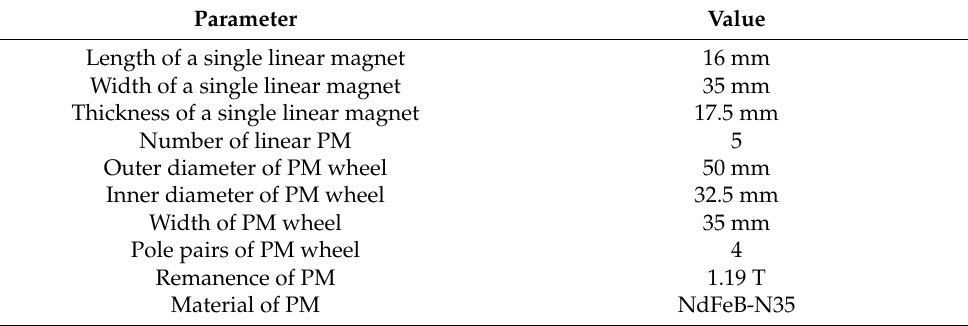
Table 3. The parameters of the linear Halbach PM and equivalent rotating PM